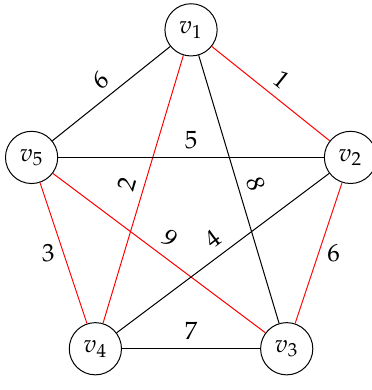
Figure 1. Example of a